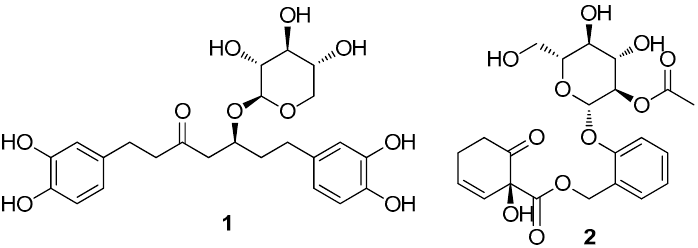
Figure 2. Chemical structure of oregonin ( 1 ) and 2 ′ - O -acetylsalicortin ( 2 ).